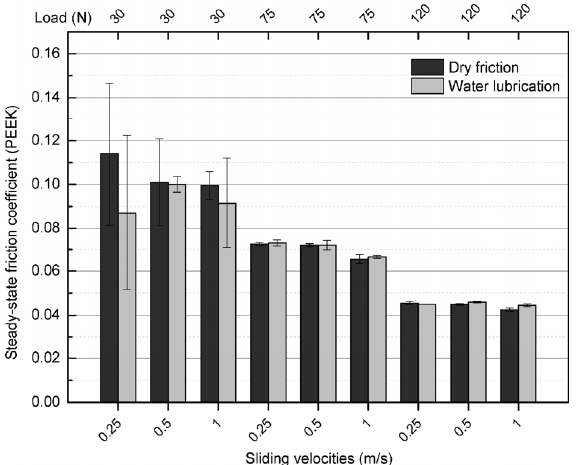
Fig. 5 The steady-state friction coefficients of PEEK–Si 3 N 4 tribopair at dry-friction and water-lubricated conditions under different loads and sliding velocities.